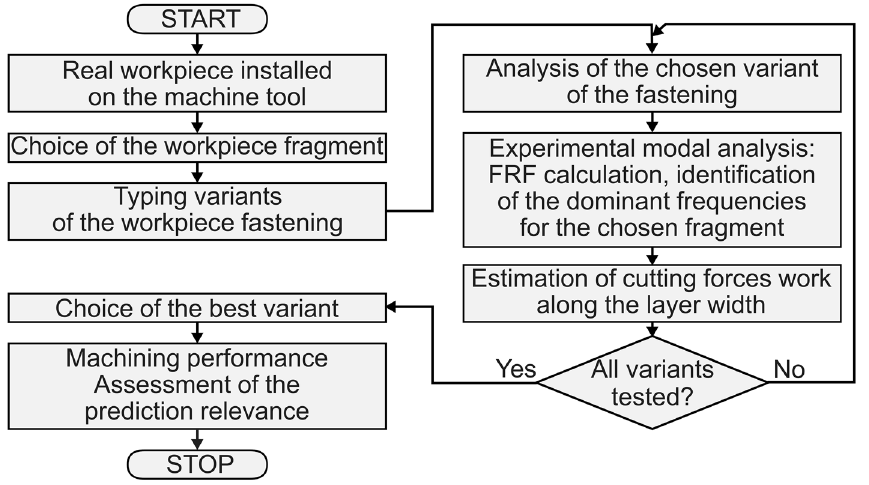
Figure 1. Scheme for finding the best conditions for fixing the workpiece by minimizing the work of cutting forces.